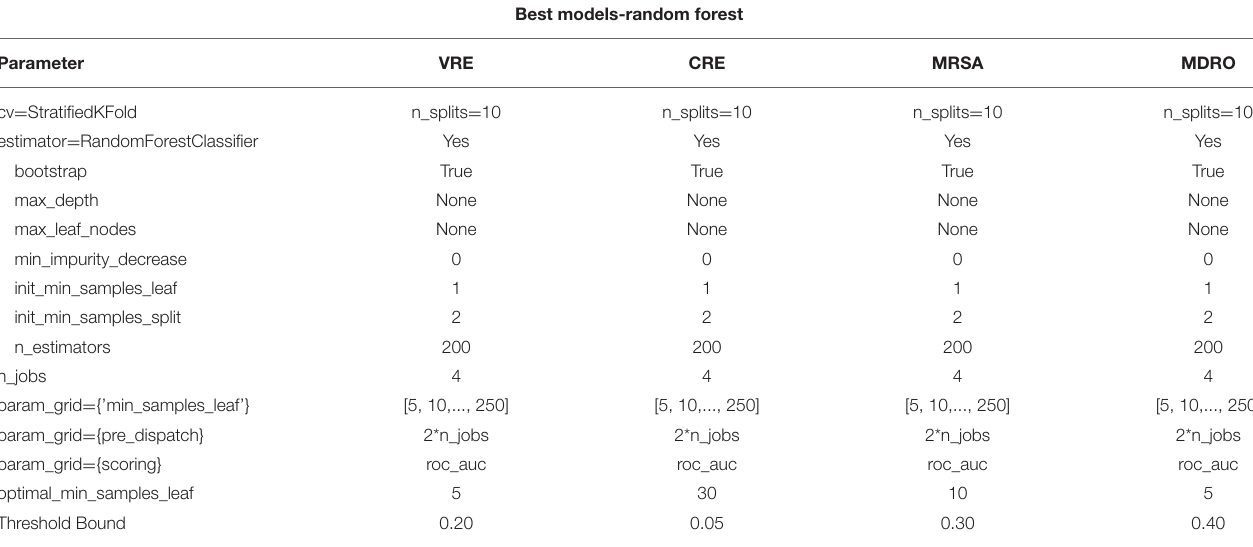
TABLE 2 | Model parameters for best performing random forest models.